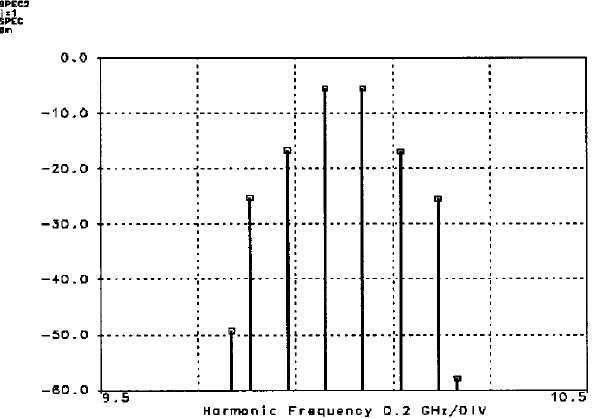
FIGURE 23 Discrete power spectral density of the output BPSK signal.